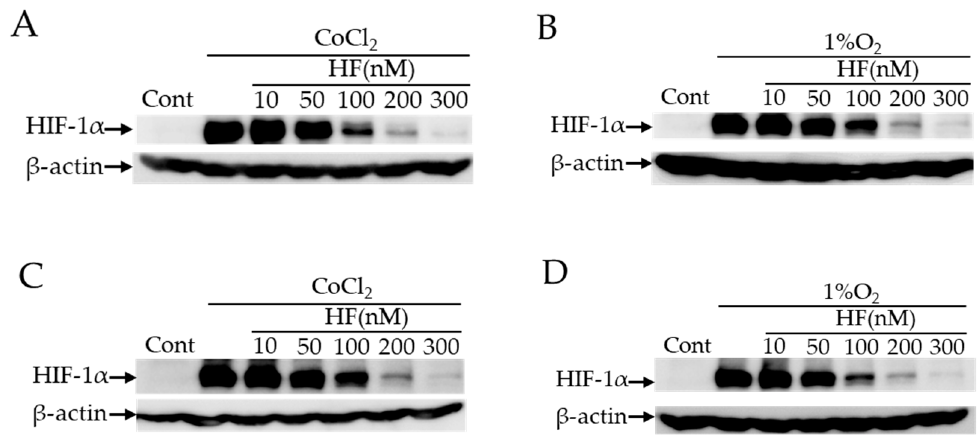
Figure 2. Inhibition of HIF-1 α protein expression by halofuginone administration in 661W and ARPE19 cells. Western blotting for HIF-1 α under CoCl 2 ( A ) or 1% oxygen conditions ( B ) in 661W cells, and under CoCl 2 ( C ) or 1% oxygen conditions ( D ) in ARPE19 cells. CoCl 2 was administrated at the concentration of 200 µ M, halofuginone was added at 10, 50, 100, 200, or 300 nM simultaneously, and cells were incubated for 6 h. The hypoxic condition was maintained in 1% O 2 for 6 h. Halofuginone inhibited HIF-1 α protein expression in a dose-dependent manner in both conditions. HF; halofuginone.